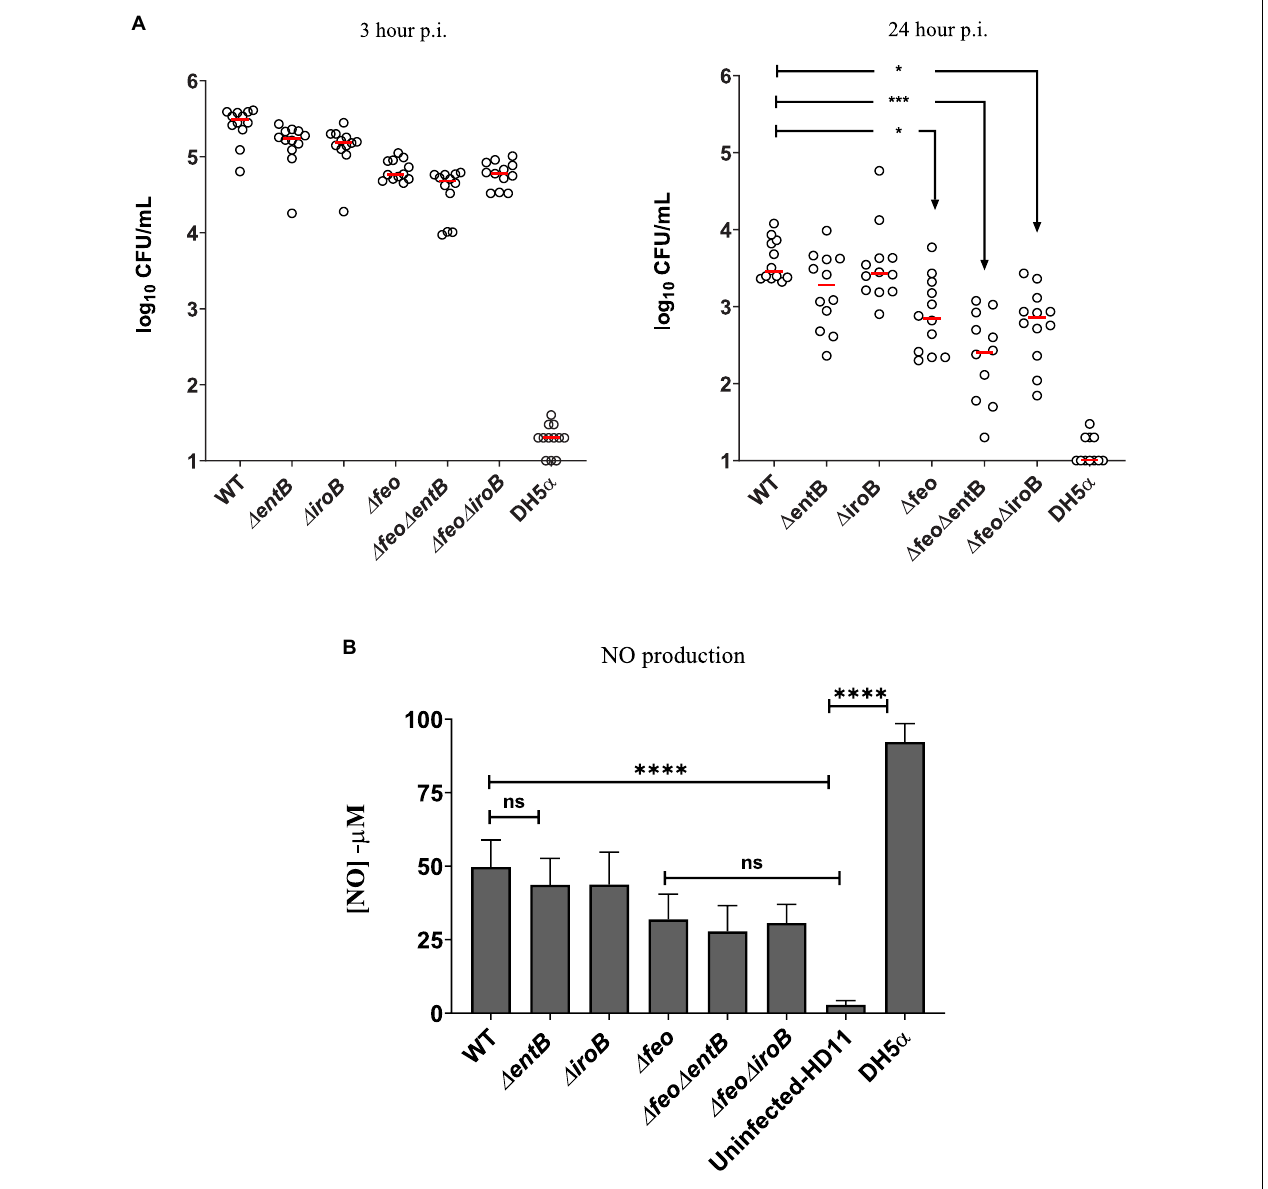
FIGURE 6 | (A) Gentamycin protection assay results at 3 and 24 h of post infection. Survived bacteria shown as CFU/ml in log10 scale. Assay was performed four times in three technical replicates for each strain. Each symbol represents one technical replicate. The detection limit of LB agar palate is 10 CFU/ml. Horizontal bar represent the median value. Mean differences was analyzed using log10 values of CFU/ml. ∗ p = 0.028, ∗ p = 0.012, ∗∗∗ p = 0.0003. (B) Nitric oxide (NO) concentration in µ M, 24 post infection. Each column represent mean with standard deviation. Data was from three assays run in triplicates. Statistical significance represents mean differences. ns, not significant, ∗∗∗∗ p ≤